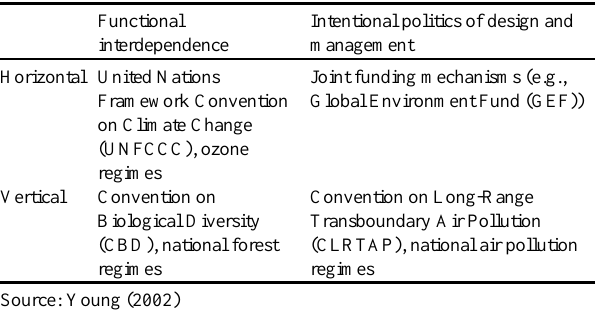
Table 2 . Types of institutional interplay. Functional interdependence